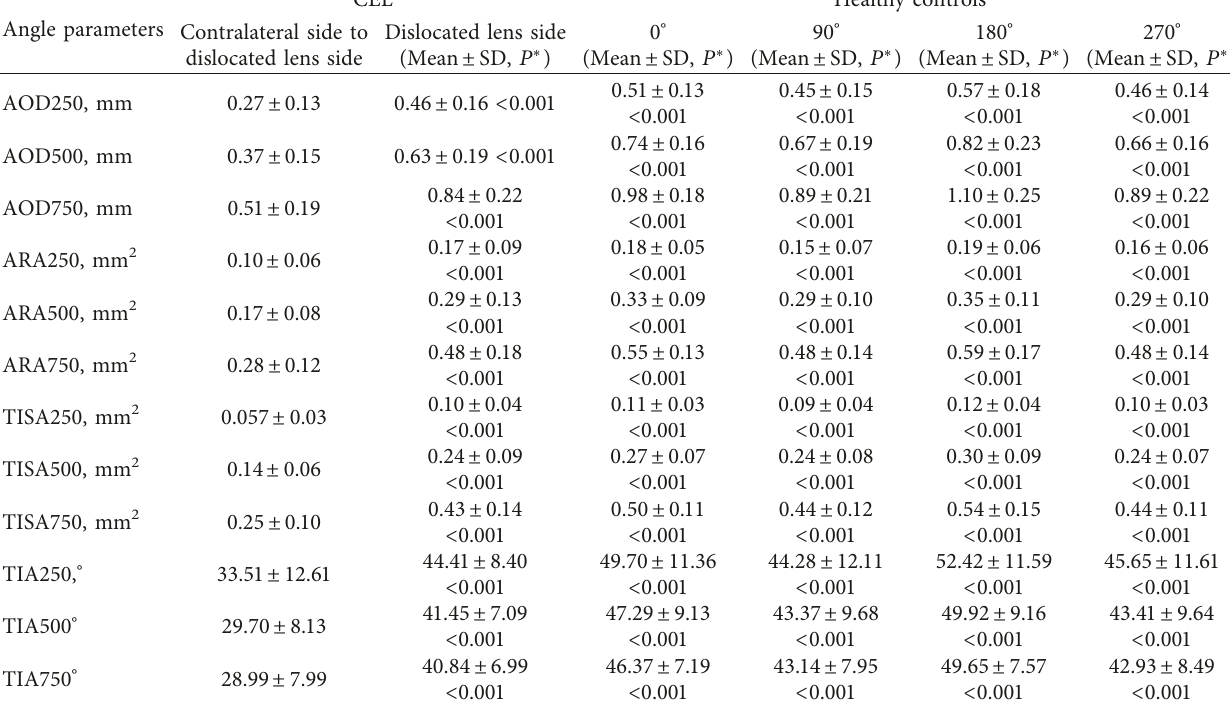
Table 2: Comparison of angle parameters in different direction in CEL patients and healthy controls.